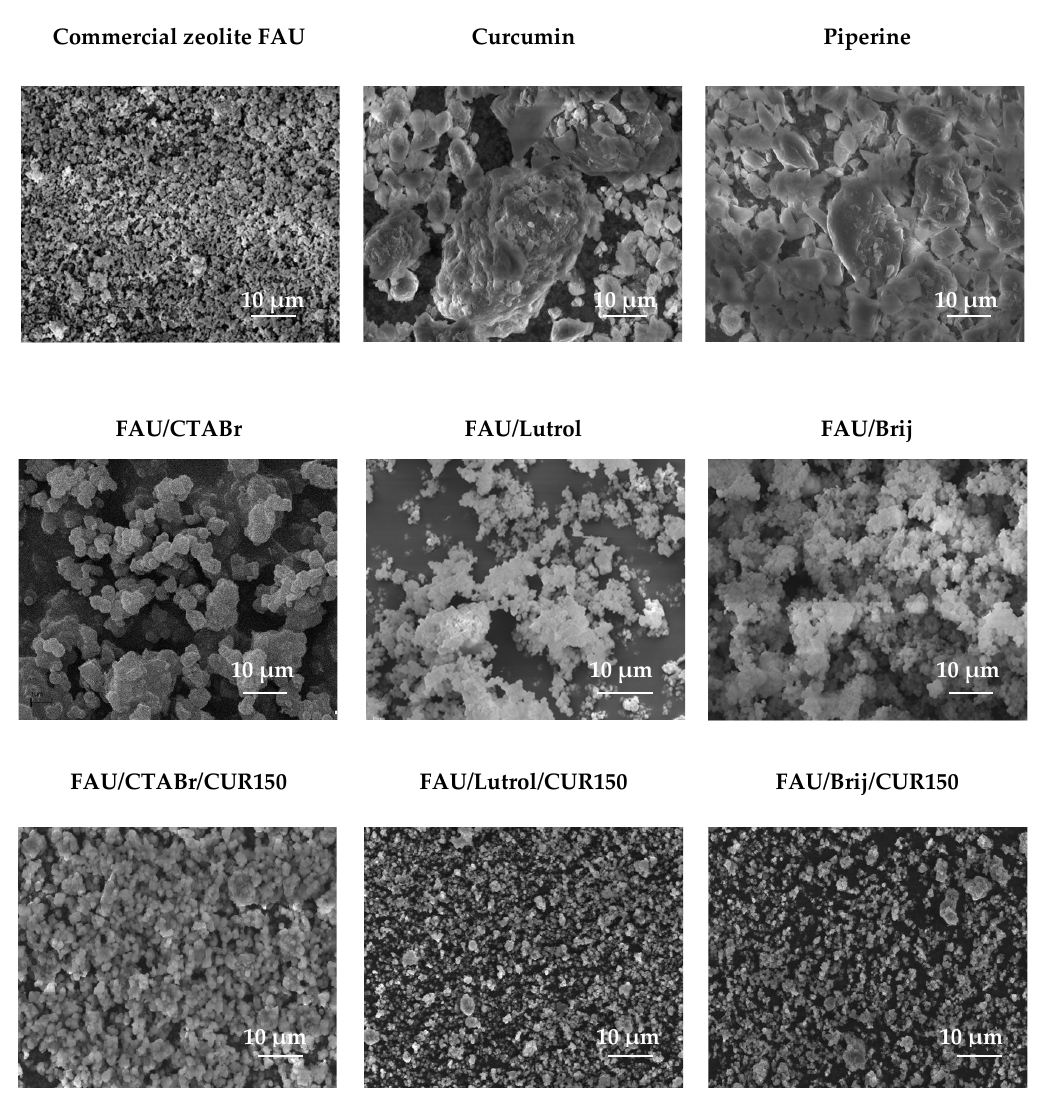
Figure 5. SEM images of the materials studied (10 μm scale bar).